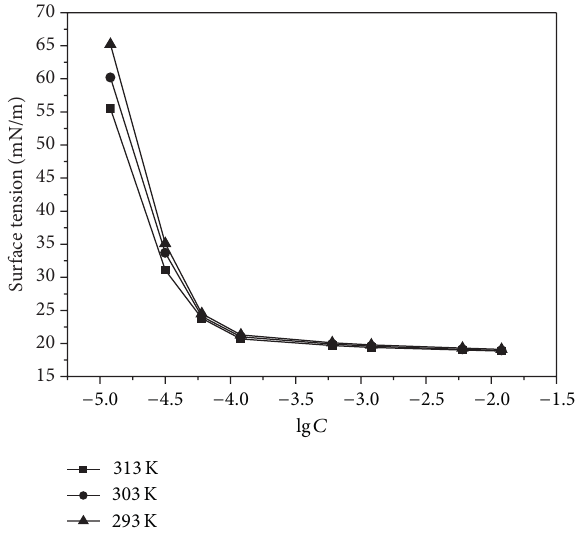
Figure2:EffectoftemperatureonsurfacetensionofFQASsolution. Figure 3: Effect of electrolyte on surface tension of FQAS solution.